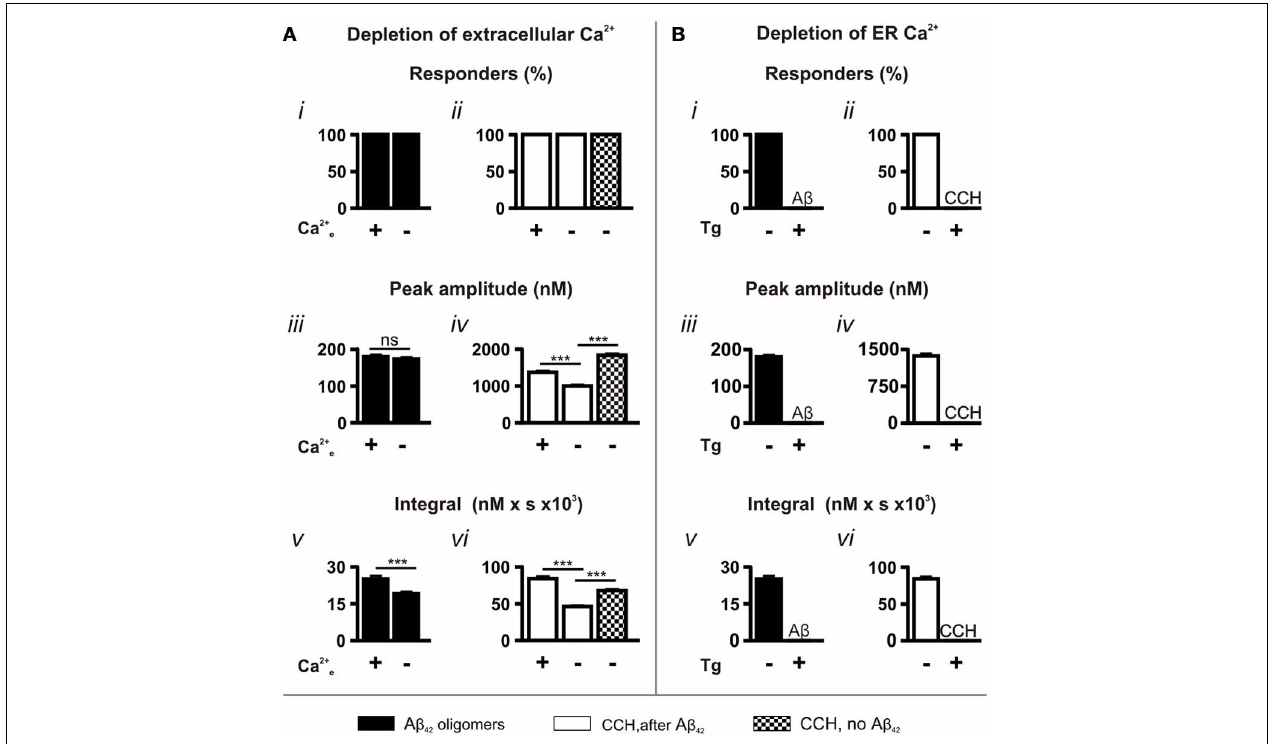
FIGURE 3 | A β 42 oligomer-induced Ca 2 + transients arise through release from the ER Ca 2 + store. Bar charts illustrating the magnitude of Ca 2 + responses elicited following the manipulation of (A) extracellular ( n > 218 cells) and (B) ER Ca 2 + concentrations ( n > 512 cells). The magnitude of Ca 2 +